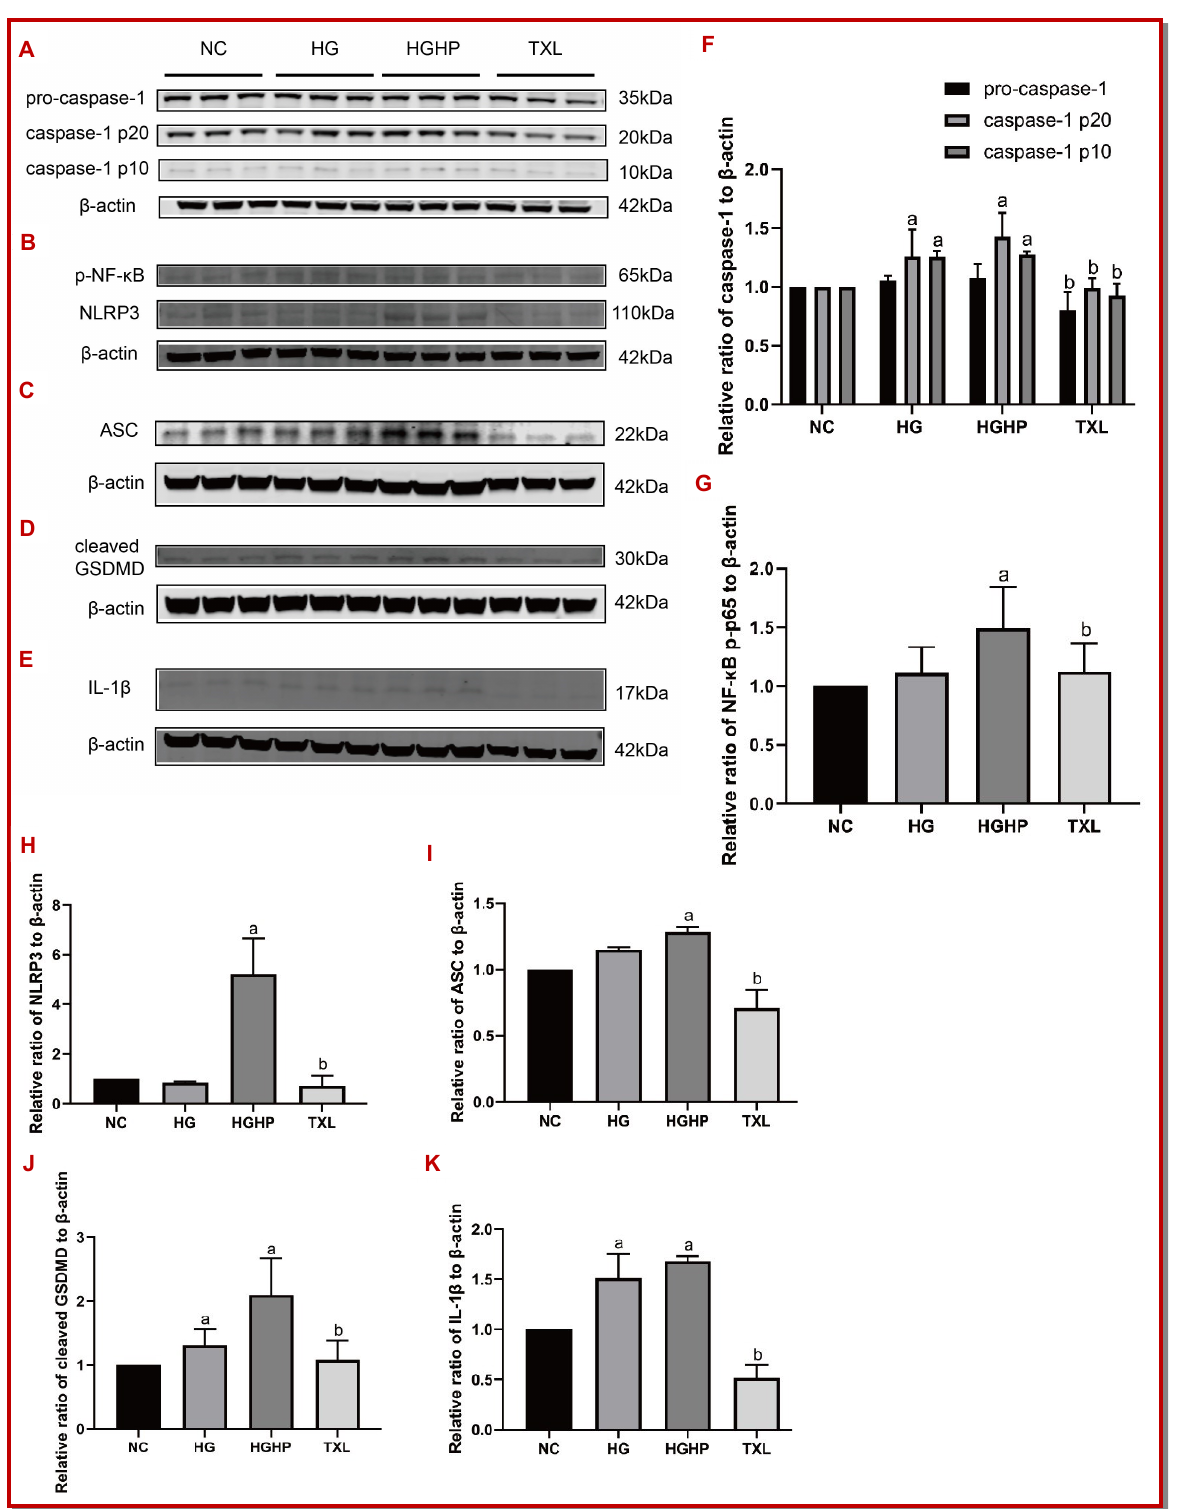
Figure 5: Effect of Tongxinluo (TXL) on pyroptosis in HK-2 cells exposed to high-glucose (HG) and high-glucose combined with high-palmitic acid (HGHP). (A~E) Representative band of NF- κ B p-p65, NLRP3, ASC, Caspase-1, cleaved GSDMD and IL-1 β by Western blot in vitro (n=3 per group) . (F~K) Semiquantitative analysis of average optical density of NF- κ B p-p65, NLRP3, ASC, Caspase-1, cleaved GSDMD and IL-1 β. The values represent means ± SEM. a p<0.05: the significant difference with respect to nor- mal control (NC) group; b p<0.05: the significant difference with respect to HGHP